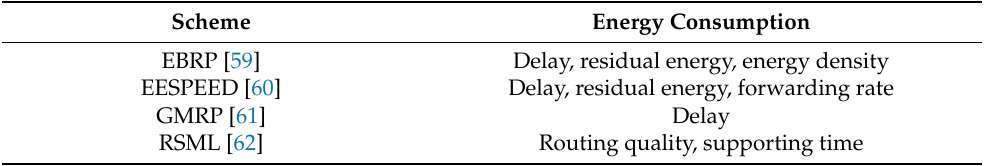
Routing quality, supporting